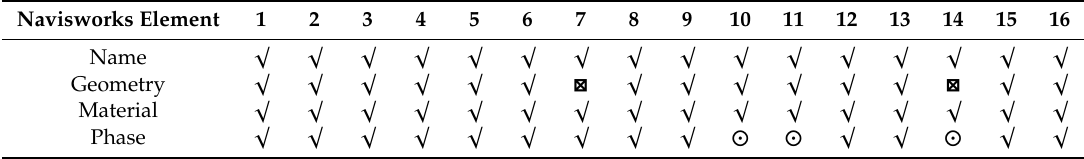
Table 2. Results of tests of BIM interoperability through the IFC standard, obtained by importing the sample IFC model into Autodesk Navisworks ( (cid:12) : no data found).